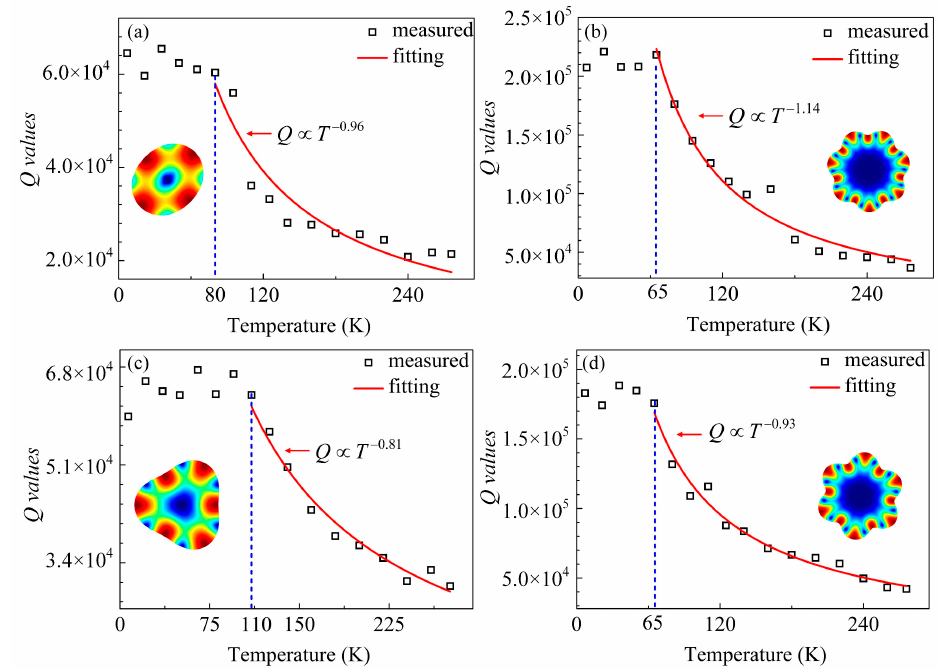
Figure 6. The Q values vs. temperature of the 2nd and 7th modes for the 37 μ m-radius resonator ( a , b ), and of the 3rd and 6th modes for the 18 μ m-radius resonator ( c , d ).